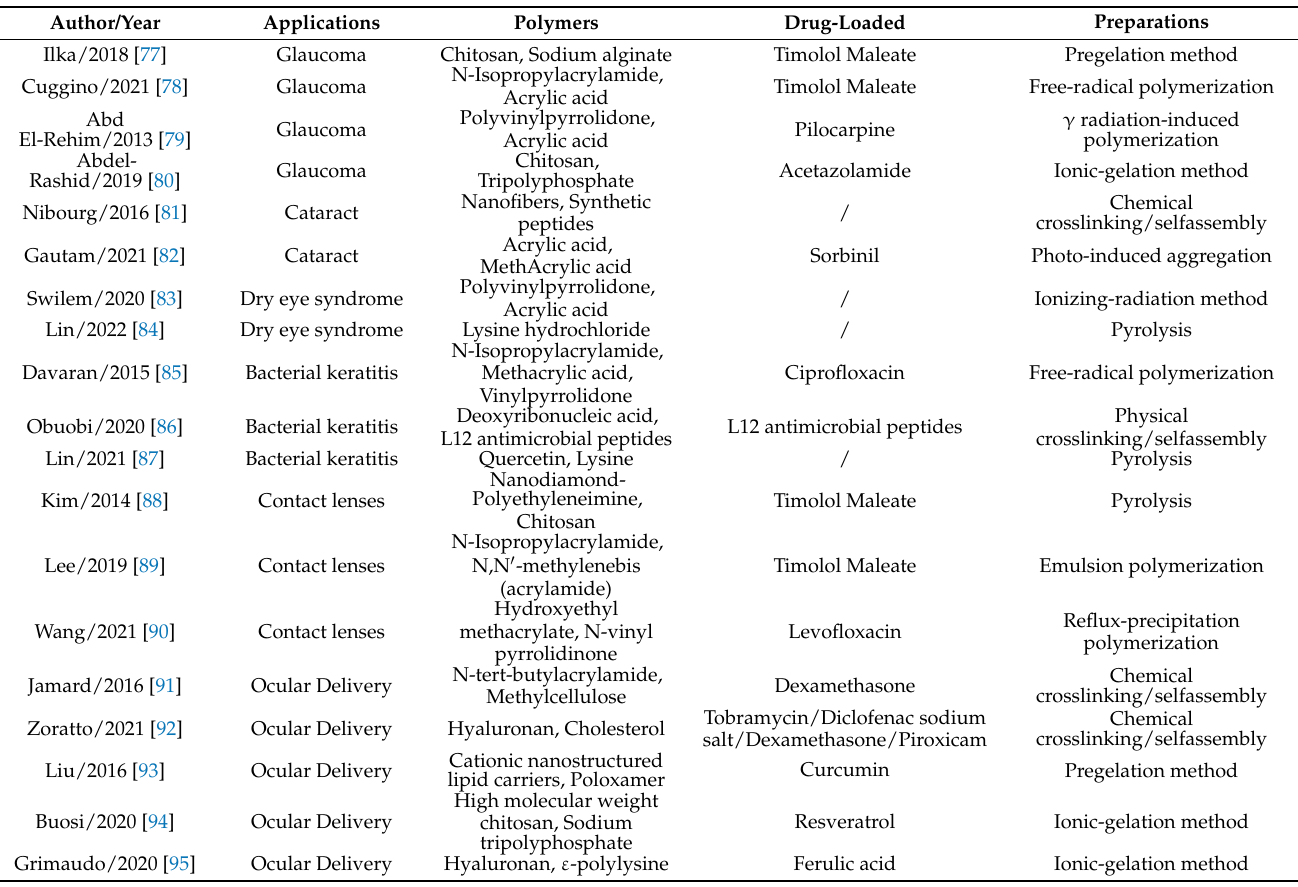
Table 1. Some examples of the ocular application of